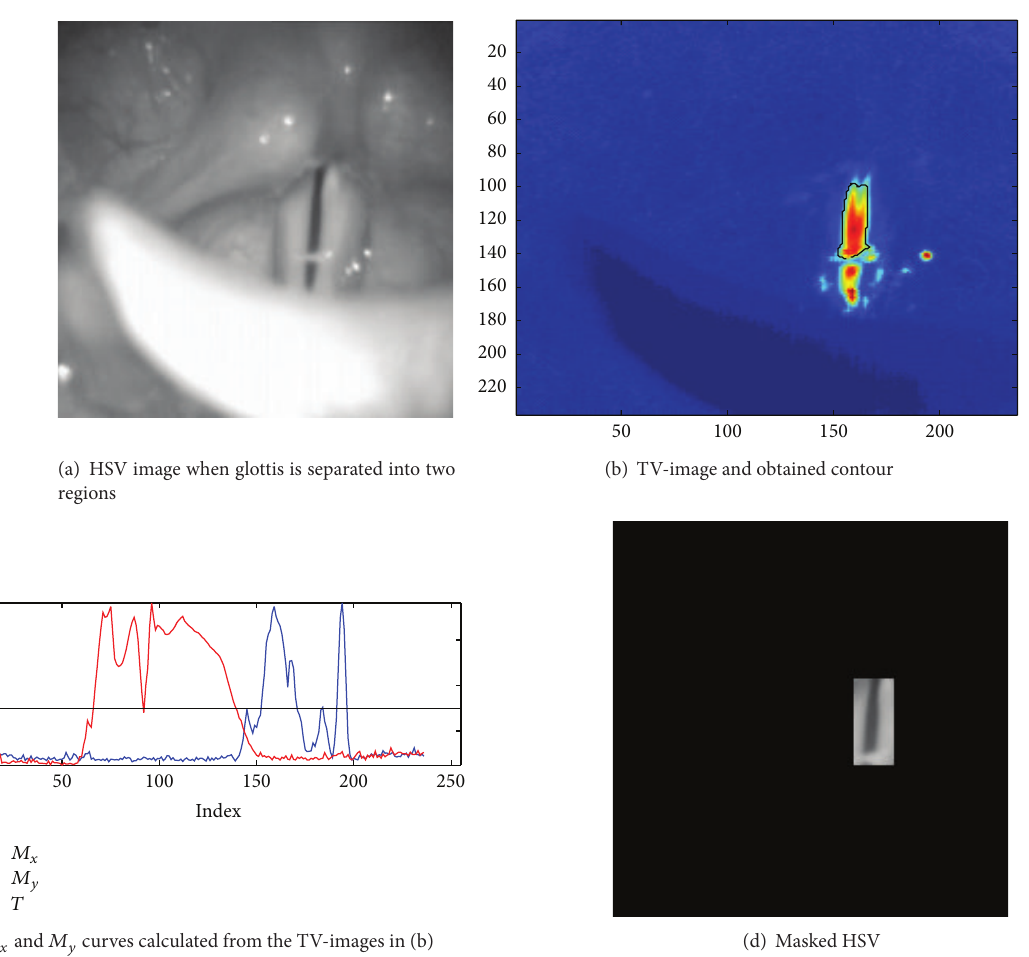
Figure 7: Application of the proposed method without 2D median filtering when glottis is separated into two regions.